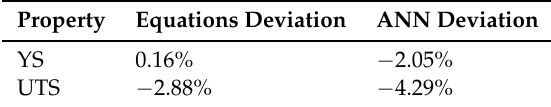
Table 8. Comparison between the predictive precision of the empirical equations and the